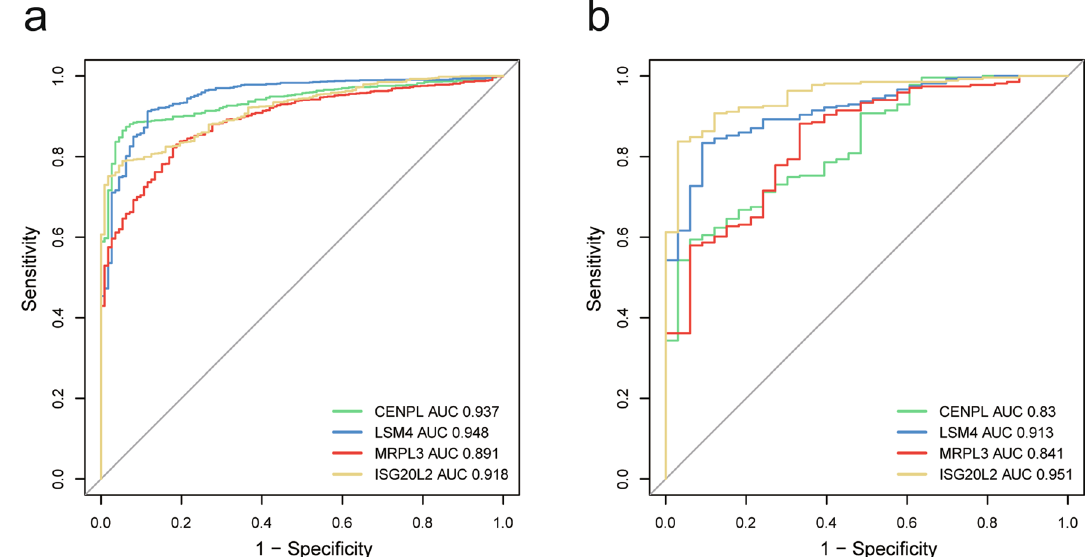
Figure 5. The diagnostic value analysis and validation of four novel hub genes in breast cancer. ROC curves analysis for CENPL, ISG20L2, LSM4 and MRPL3 based on ( a) TCGA dataset, ( b) GEO_BRCA dataset. Abbreviation: ROC receiver operating characteristic, AUC area under the ROC curve.